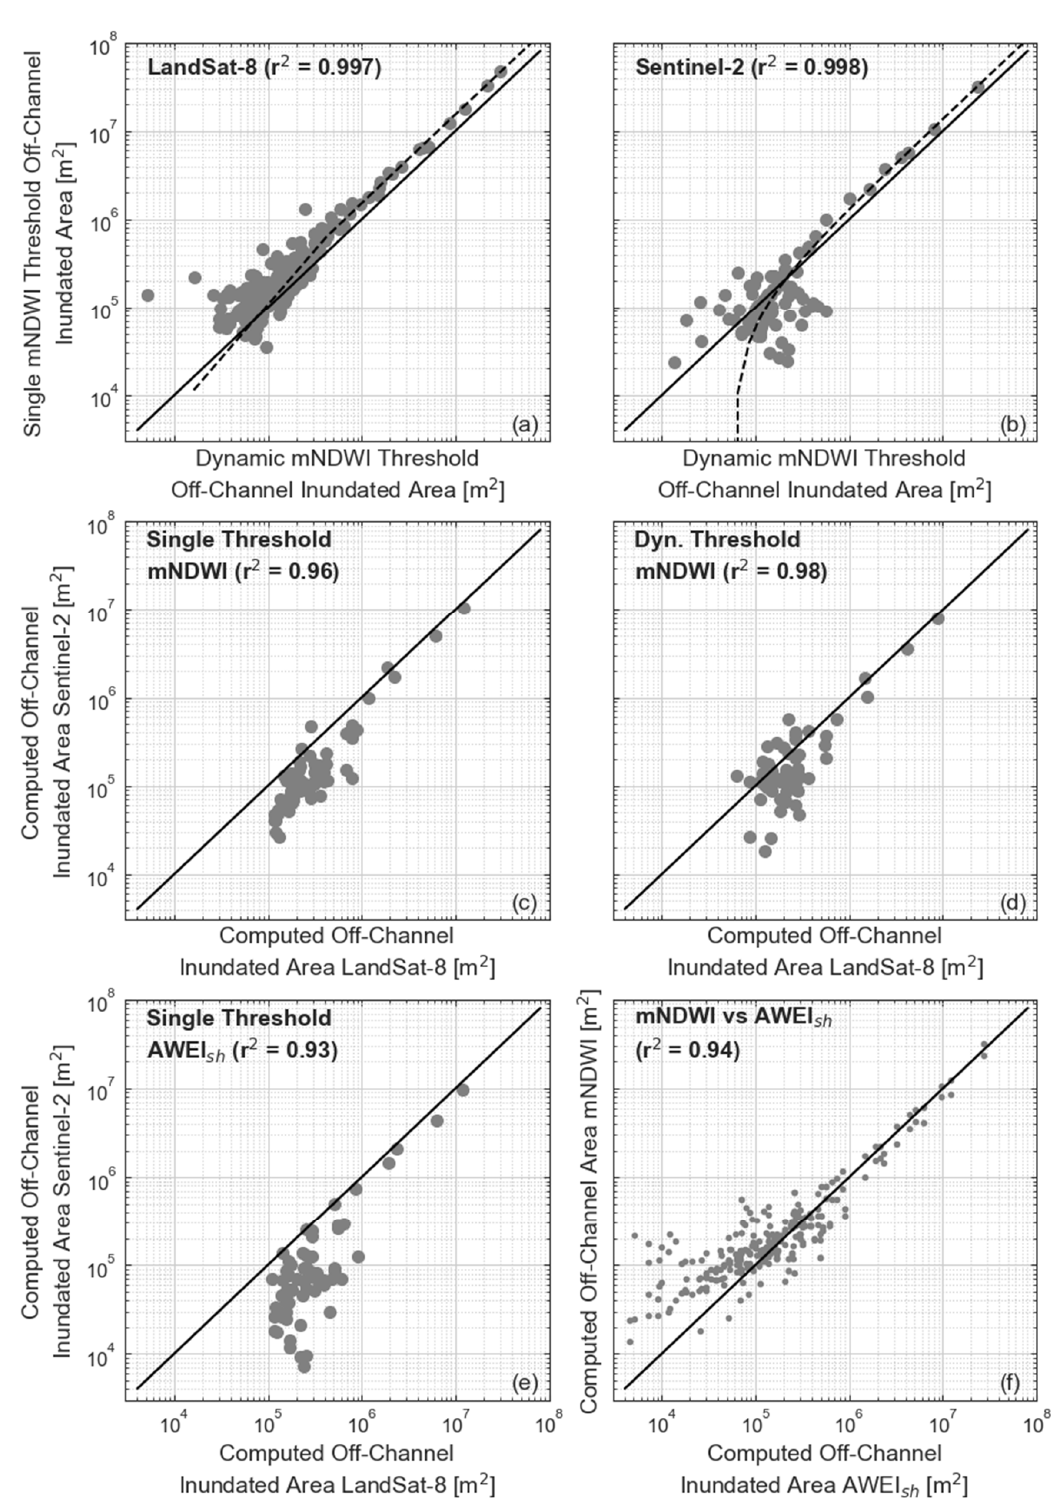
Figure 7. Comparison of computed inundated areas using the different considered procedures: ( a ) dynamic mNDWI threshold versus single mNDWI threshold for LandSat-8; ( b ) Dynamic mNDWI threshold versus single mNDWI threshold using Sentinel-2; ( c ) mNDWI single threshold using LanSat-8 versus using Sentinel-2; ( d ) mNDWI dynamic threshold using LandSat-8 versus using Sentinel-2; ( e ) AWEI sh using LandSat-8 versus Sentinel-2, and ( f ) mNDWI (single and dynamic thresholds) vs. AWEI sh estimates using both LandSat-8 and Sentinel-2 products.